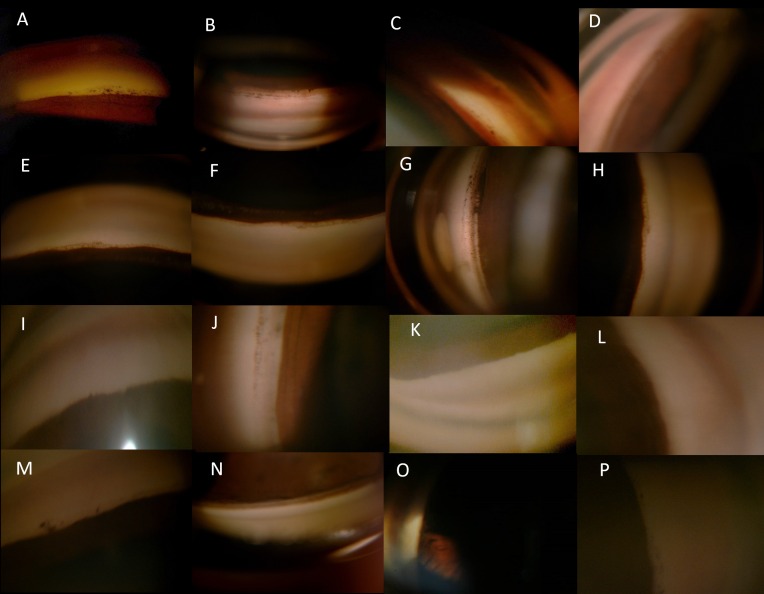
Comparison of 4 quadrant (from left to right superior, inferior, temporal and nasal in that order) gonioscopic features of eyes with primary angle closure requiring 0 medicines (a-d) with that requiring 1 medicines (E, F, G and H) or 2 medicines (I, J, K & L and M,N, O &P) showing increasing quadrants of peripheral anterior synecheiae/blotchy pigments/non-visibility of posterior trabecular meshwork and narrower recess with increasing need for number medicines.